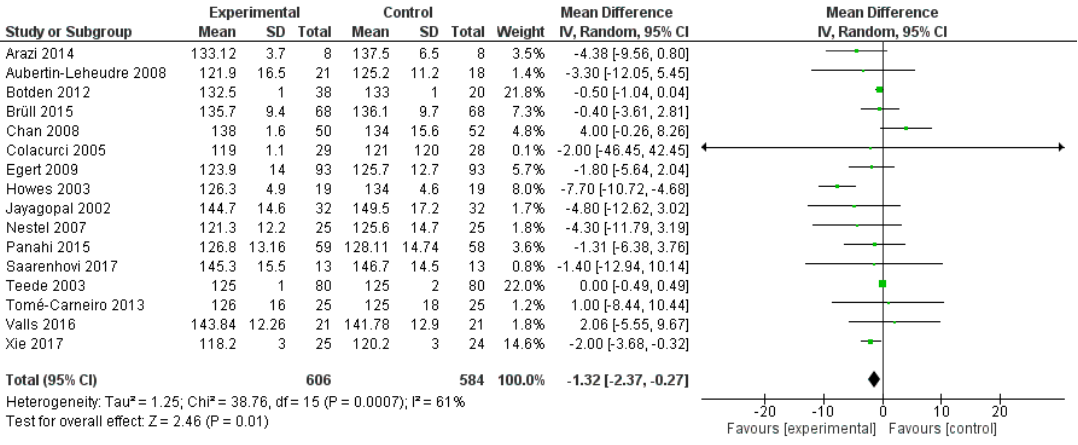
Figure 2. Pooled analysis of association between polyphenol intake and systolic blood pressure (SBP). The green square represents the mean difference detected in each study. The black diamond shows the final overall mean difference.